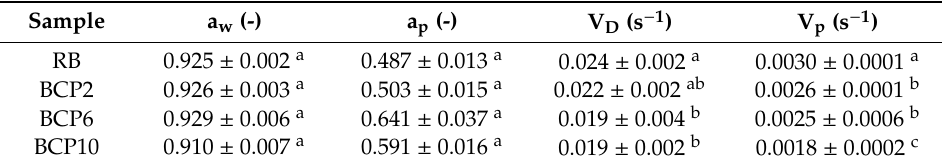
Table 3. The results of water activity.